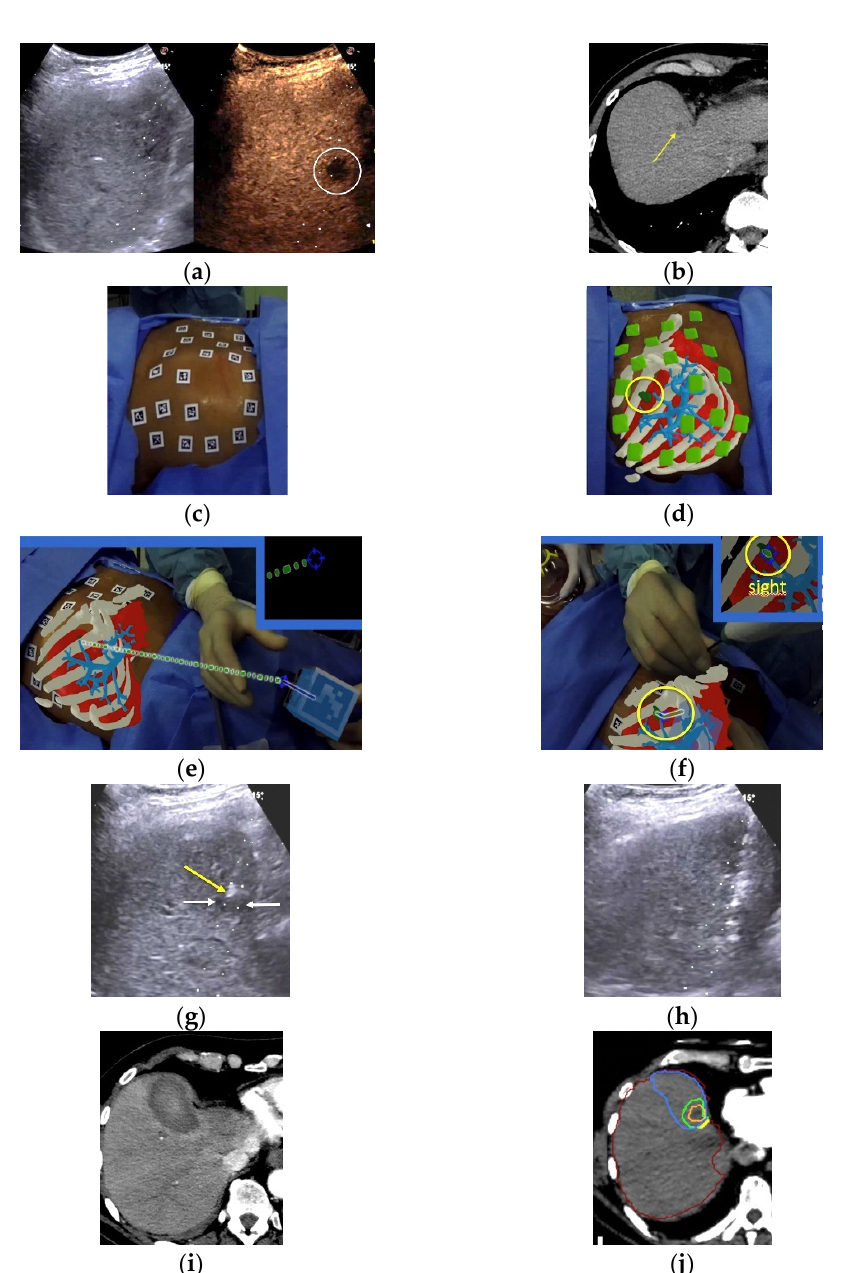
Figure 1. Augmented reality guided ablation: a 1.5-cm pancreatic carcinoma metastasis at segment VIII, poorly visible on B-mode US and clearly seen by CEUS ( a ), and seen on pre-ablation CT scan (arrow) ( b ). Radiopaque markers with no repetitive pattern applied to the patient’s skin ( c ). View through the operator’s HMD: ribs (in white), major hepatic blood vessels (light blue), liver (red), and target lesion (green, in a yellow circle) ( d ). View through the HMD, showing that the operator can see the virtual needle (blue line) and the line that connects the tip of the needle to the center of the target (in green) ( e ). Following the trajectory line permits successful tumor targeting with AR guidance alone ( f ). The 5.4-mm distance between the tip of the coaxial needle and the target center by US ( g ). Subsequently, the microwave antenna is inserted into the coaxial needle ( h ). On a post-ablation CT scan, a large ablation volume completely surrounds the metastasis ( i ). Using ablation confirmation software (Ablation-fit TM ), the technical success achieved was precisely demonstrated. The margins of the target tumor are shown in orange, the 5-mm ablation margin is shown in green, and the margins of the necrosis volume are shown in blue. Complete tumor ablation with only 5.4% of the safety margin out of the necrosis volume was achieved ( j ).